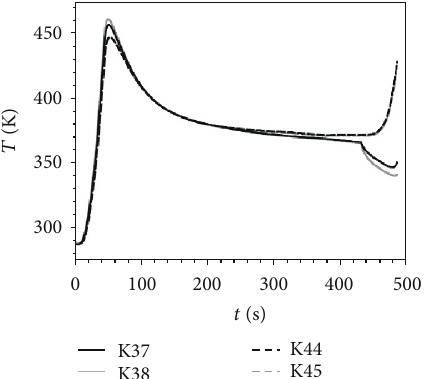
Figure 22: Comparison of sample temperatures on AKTiV and the reference